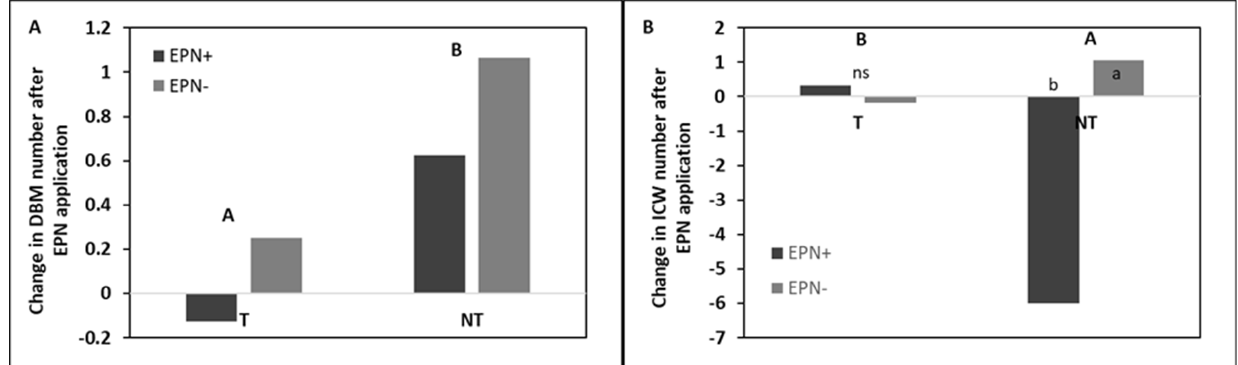
Figure 5. Effect of entomopathogenic nematodes (EPN) on the reduction in number of ( A ) Diamond- back moth (DBM); ( B ) Imported cabbageworm (ICW) before and one week after EPN application in trap crop (T) and no trap crop (NT) plots on head cabbage in Trial I. Means (n = 16) of trap crop treatments or EPN treatments followed by the same letter were not different according to analysis of variance. ns = no significant difference between EPN+ and EPN − .